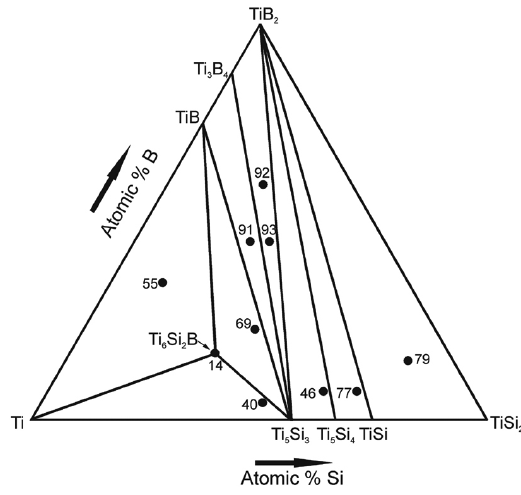
Figure 2. Isothermal section of the Ti-Si-B system at 1250 °C in the Ti-TiSi -TiB region from results of this 2 2